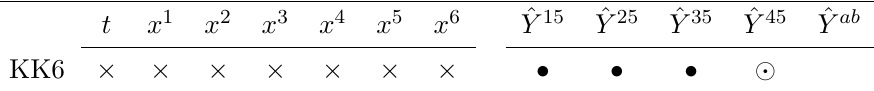
Table 4 . The trivial lift of the KK6 background to EFT, identifying the internal space with a subset of the extended space. In this frame, the section aligns with the eleven-dimensional physical spacetime, namely ( x (cid:22) ; ^ Y a 5